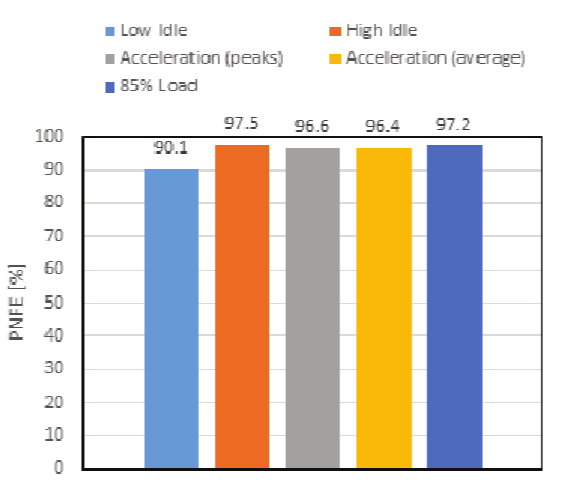
Fig. 2. PNFE as a function of engine operating regime